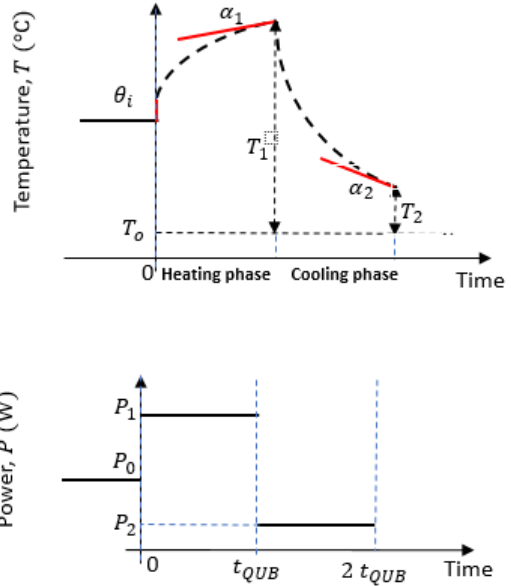
Figure 1. QUB (Quick U-Value Building) test method and steps.